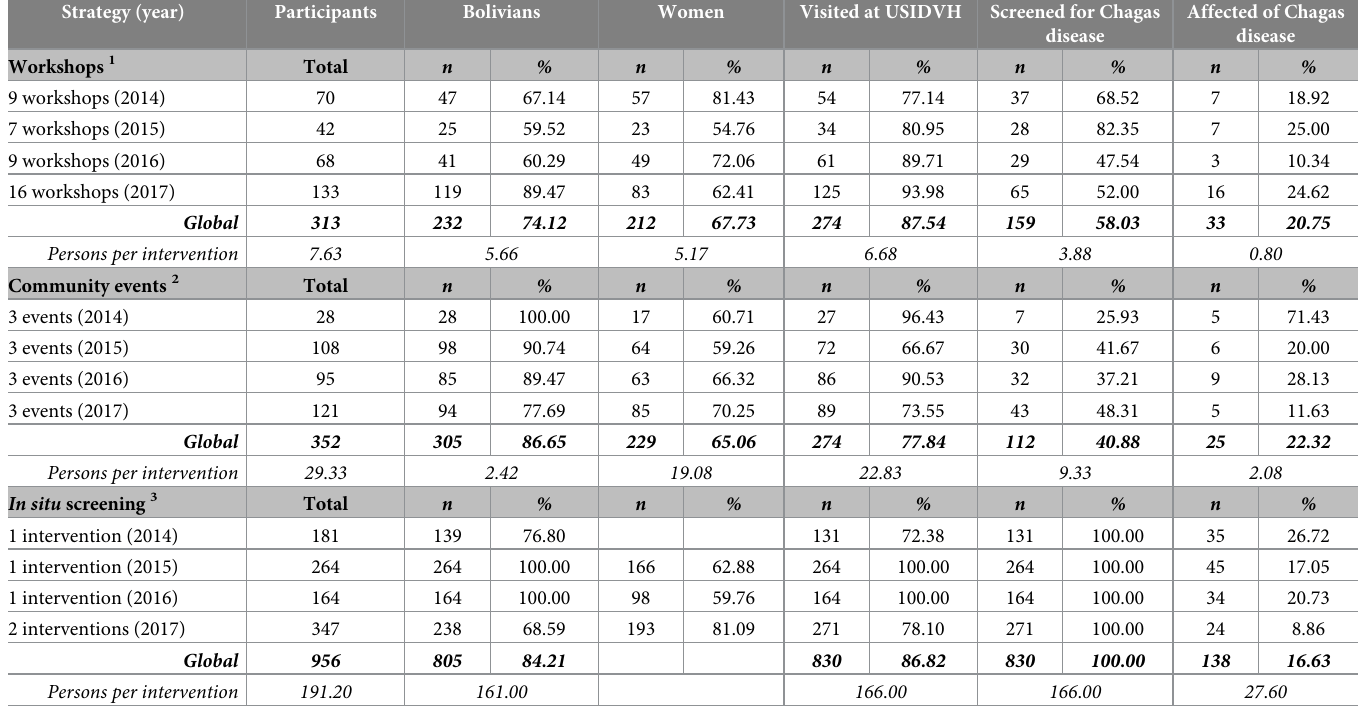
Table 3. Summary of the results obtained in the different community strategies implemented between